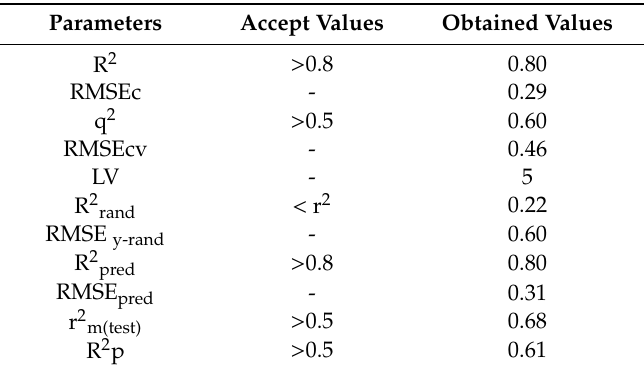
Table 3. Statistical parameters evaluated in the analysis.